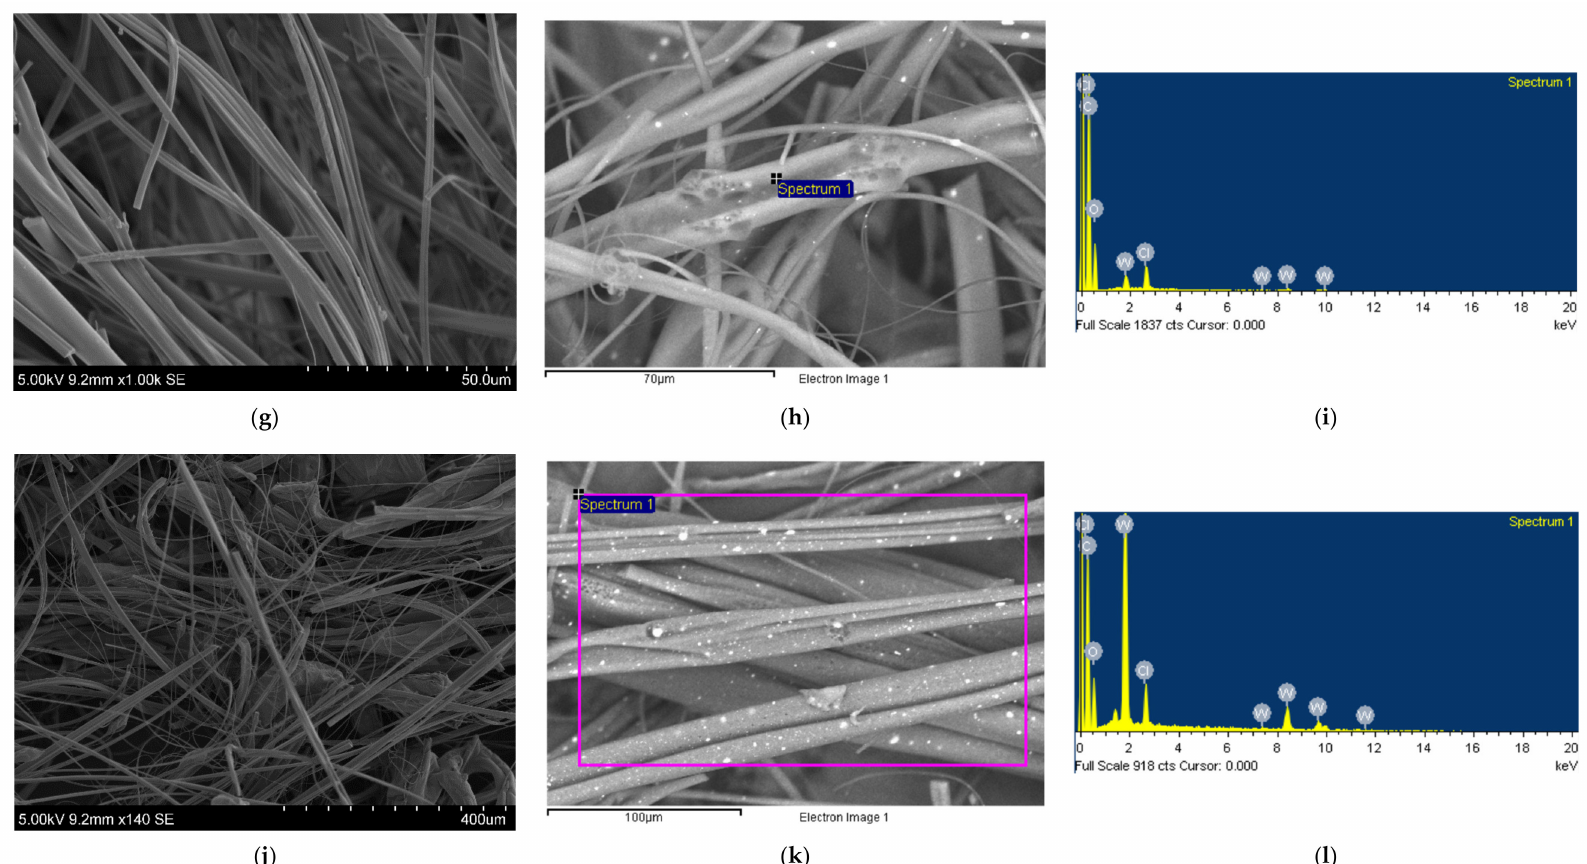
Figure 5. Scanning electron microscope images and EDX spectra ( a – c ) pure PMMA fibres; ( d – f ) PMMA fibres with 2 wt % of WO 3 ; ( g – i ) PMMA fibres with 4 wt % of WO 3 and ( j – l ) PMMA fibres with 8 wt % of WO 3